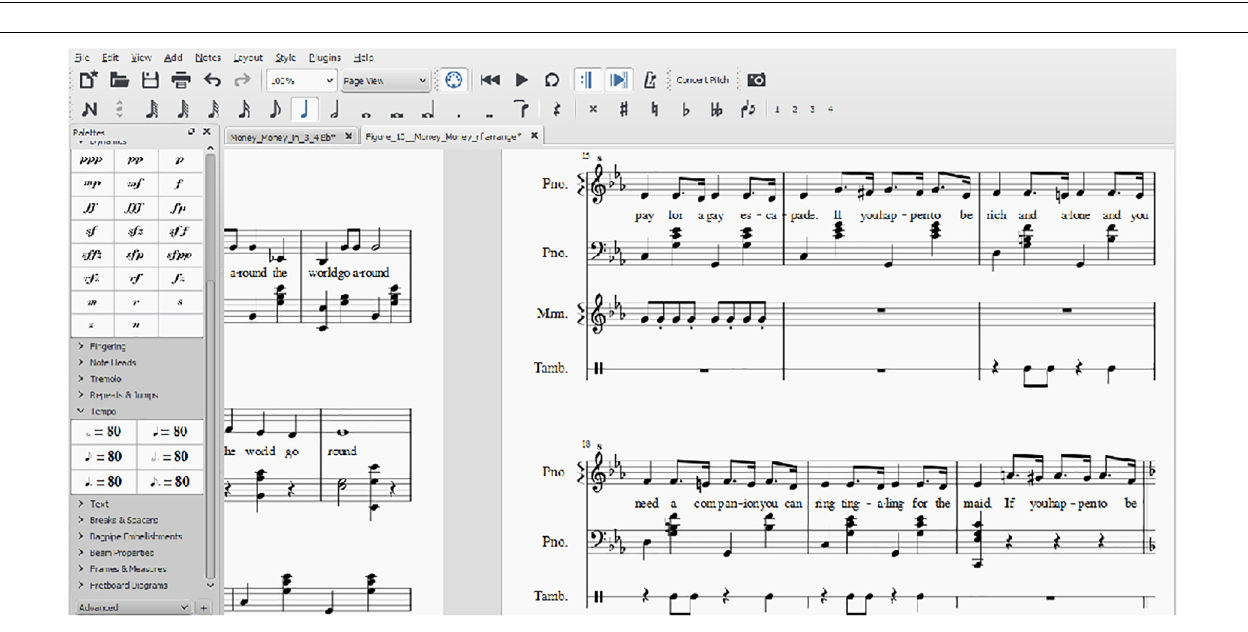
instrument lines with selected timbres, although any of the above settings can be changed in the process accordingly.